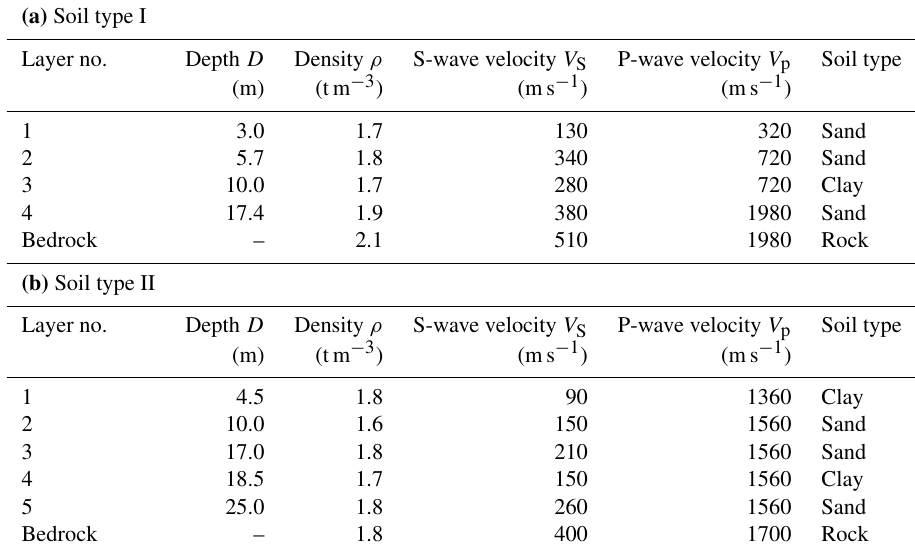
Table 3. The description of one-dimensional layered soil models.